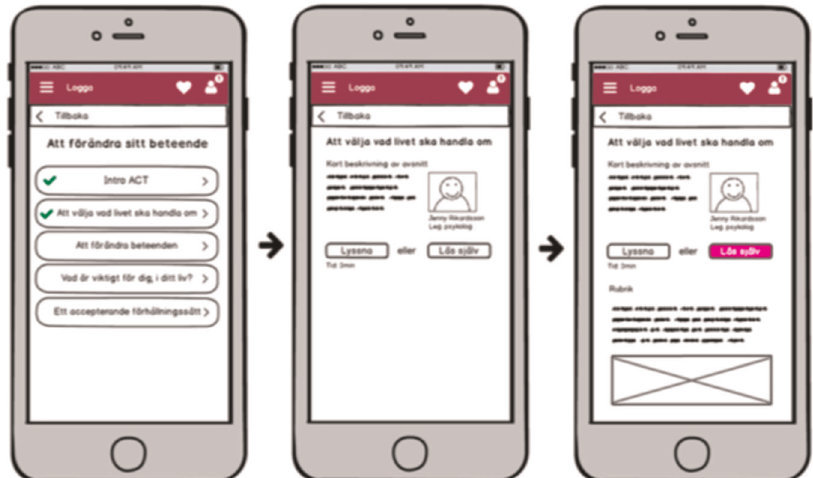
Fig. 2 Paper sketches of patient interface used in alpha testing (the native